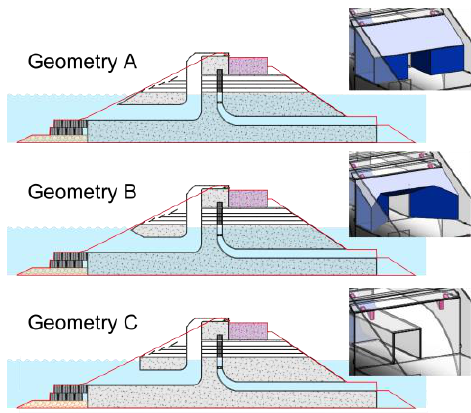
Fig. 4. Three geometries tested to determine the best overall efficiency, with the breakwater’s cross -section contour in